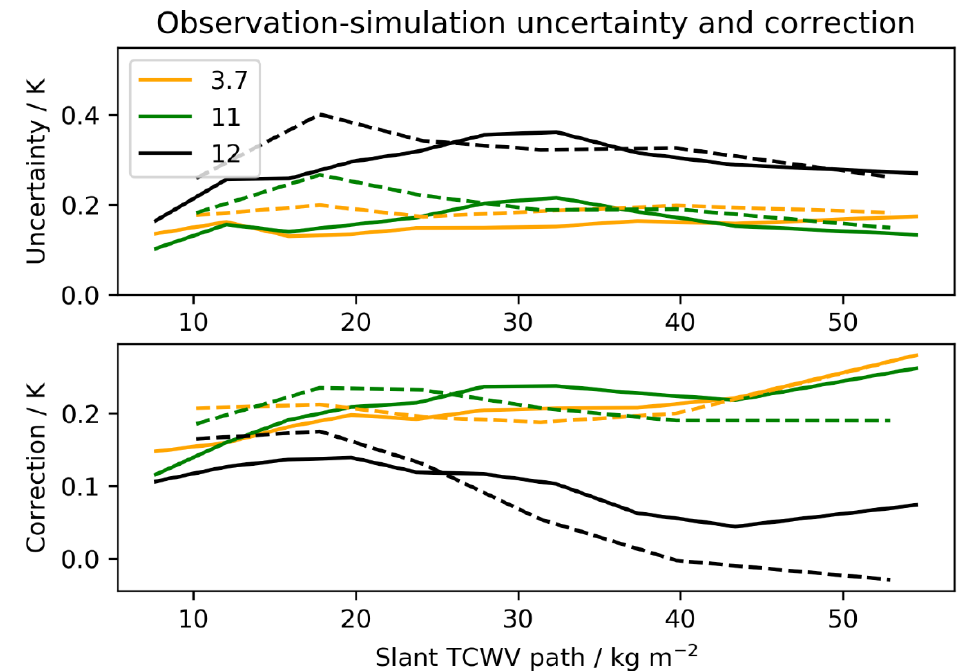
Figure 3. Parameters for optimal estimation related to the di ff erence in observed and simulated brightness temperature, for MTA channels at wavelengths around 3.7, 11 and 12 µ m, estimated as a function of the slant column WV path along the view angle. Upper panel: uncertainty (arising from instrument and forward model errors). Lower panel: bias correction (to be added to forward model results). Solid lines: estimate with reference to AATSR. Dashed lines: estimate with reference to SLSTR-A.